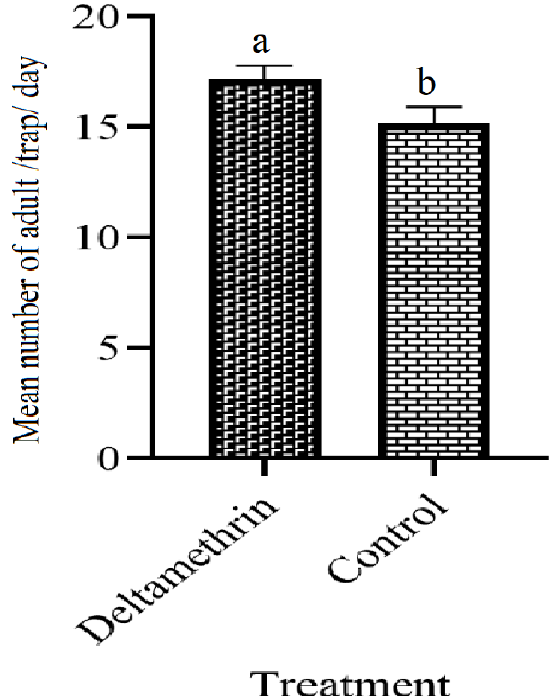
Figure 6. Adults collection from treated and untreated areas before installation of lethal ovitraps. These letter shows significant difference among